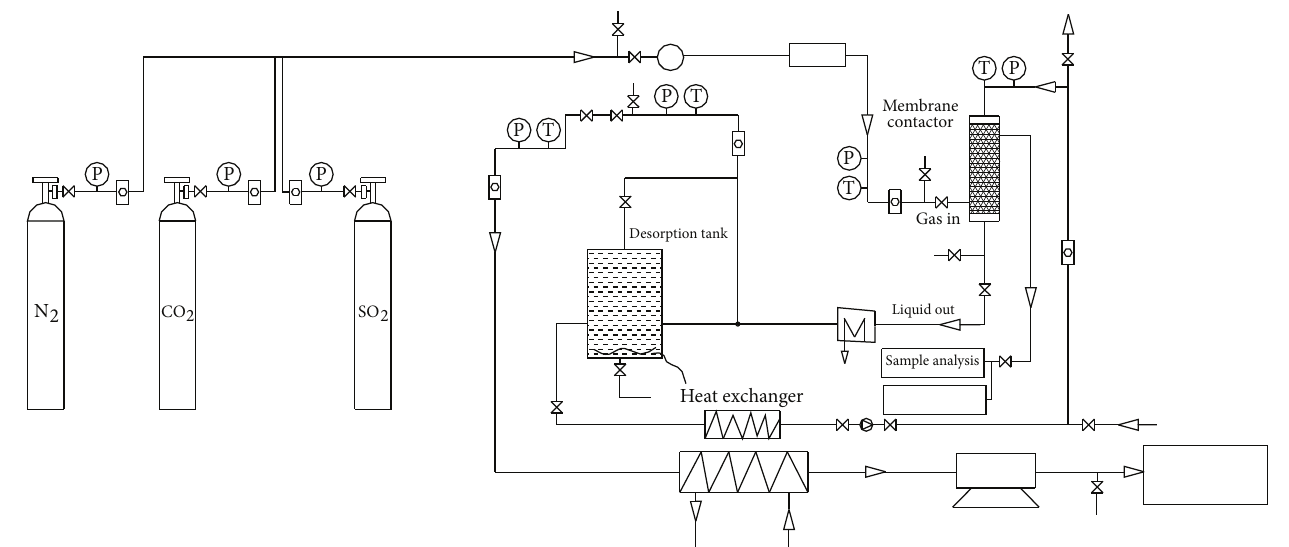
Figure 1: Flow chart of the experiment using the flue gas.